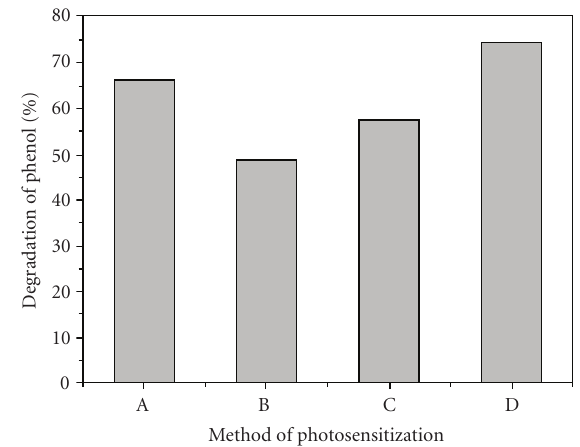
Figure 4: Photodegradation of phenol using PFT30-sensitized TiO 2 with di ff erent methods of photosensitization. A: PFT30/THF so- lution added to TiO 2 /ethanol suspension quickly. B: TiO 2 /ethanol suspension added to PFT30/THF solution quickly. C: PFT30/THF solution added to TiO 2 /ethanol suspension in two parts. D: PFT30/THF solution added dropwise to TiO 2 /ethanol